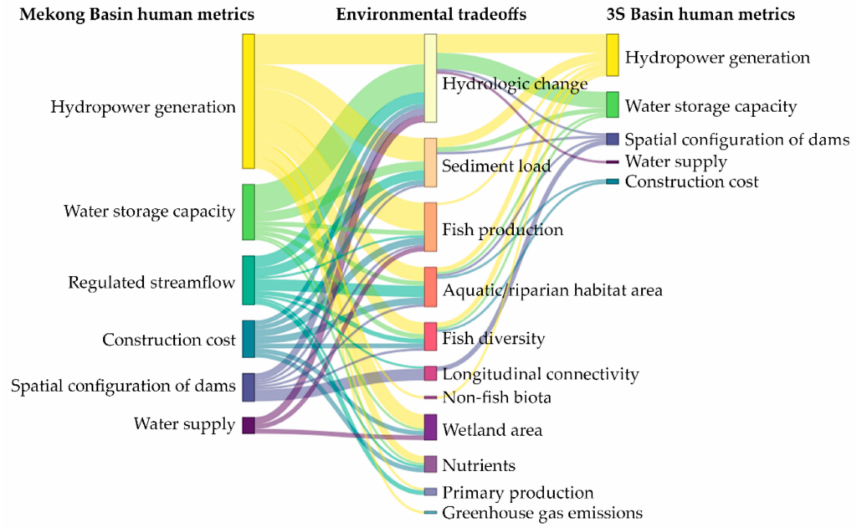
Figure 5. Human objectives of dams mapped to environmental losses that have been studied in the Mekong and 3S Basins. The width of the links is proportional to the frequency that tradeoffs have been